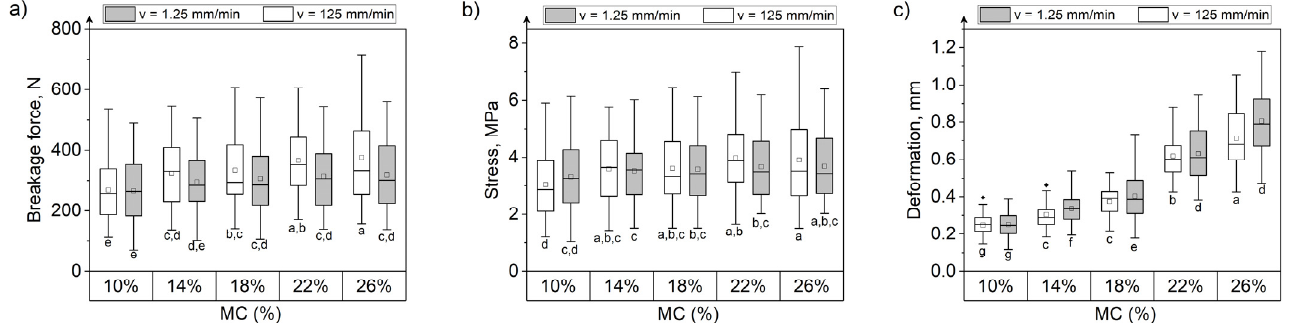
Figure 9. The breakage force ( a ), stress ( b ), and deformation ( c ) during maize grain compression at five levels of moisture content and two loading rates. Letters below the box charts are the interaction grouping letters from the post hoc Fisher least significant difference means comparison test. Means outliers.